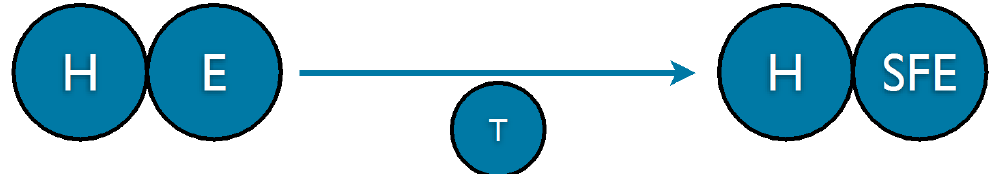
Figure 1. Technology mediated experience, shared felt experience, SFE (H = human, E = experience, T = technology).